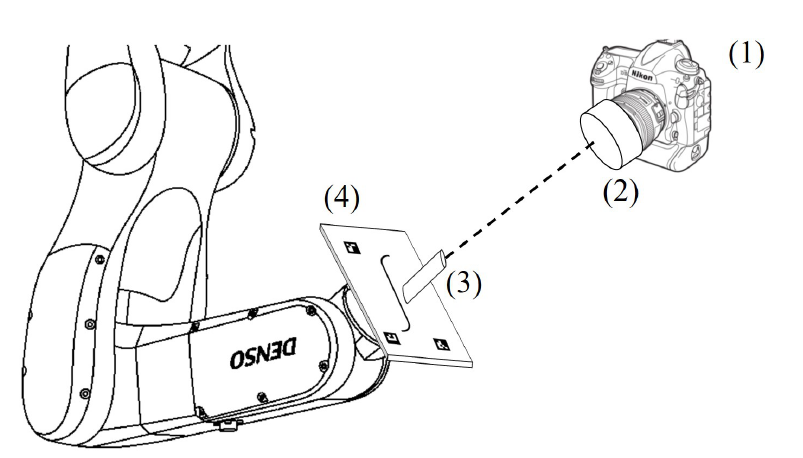
Figure 16. The image acquisition system (1) is placed at a known distance from the target (4). The parallelism between the sensor surface and the target surface is guaranteed through a system made of a laser (3) and a mirror (2). The two surfaces are to be considered parallel when the laser beam reflected by the mirror returns back to the